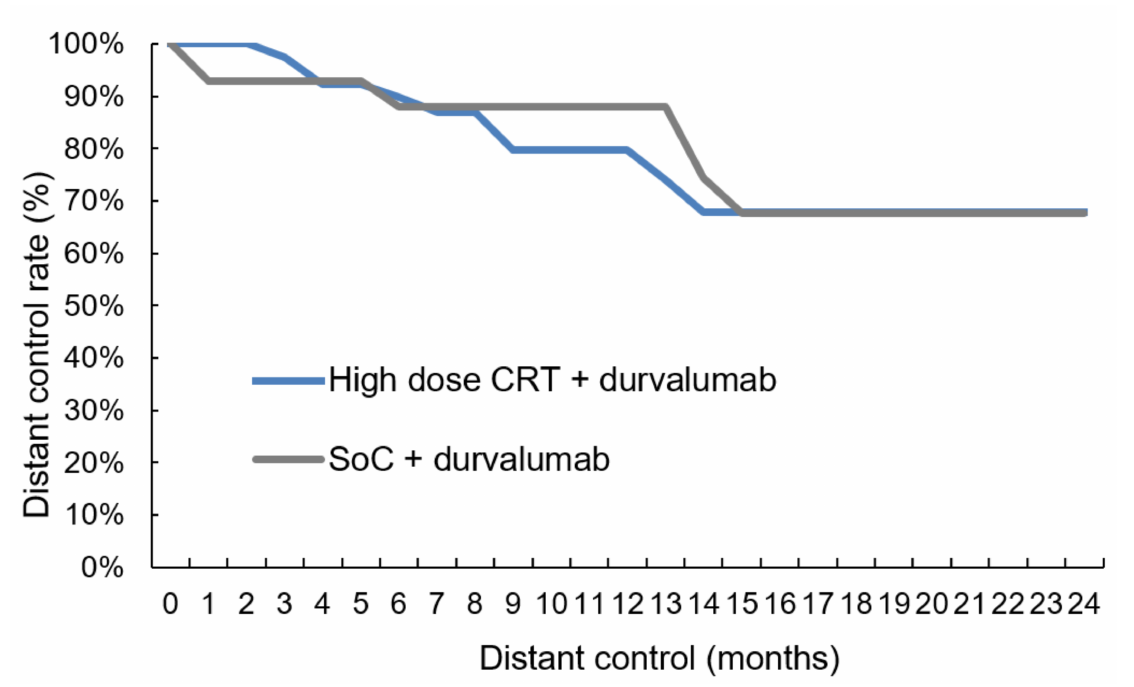
Figure 4. Distant control. The comparison revealed no difference in distant control between high- dose chemoradiation and SoC treatment (log-rank test, p -value = 0.763): CRT = chemoradiotherapy, SoC = standard of